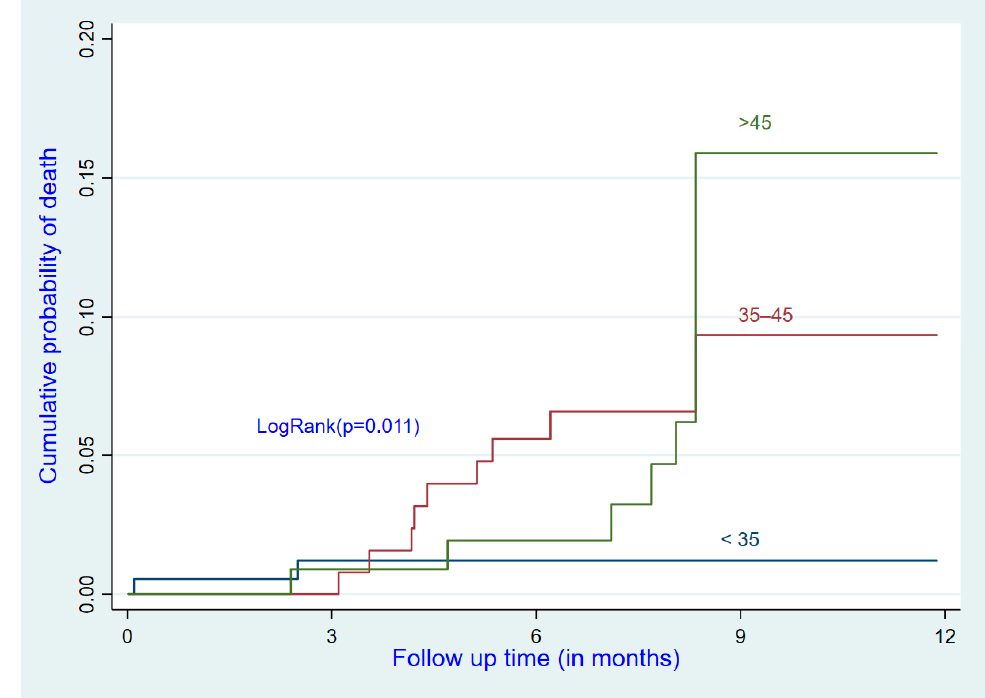
Figure 1. Cumulative incidence of death by age group.